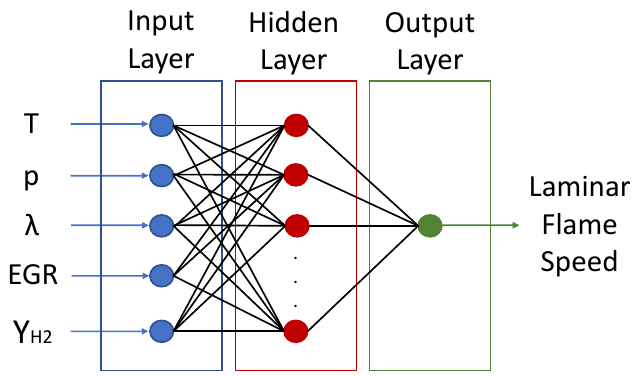
Figure 4. Validation of methane-H 2 laminar flame speed for different air-to-fuel ratios. The hydrogen percentage is expressed in the volume percentage of the total fuel volume.